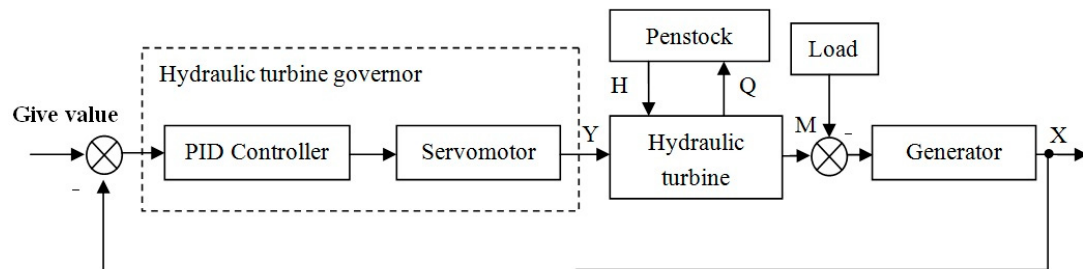
Figure 5. Diagram of the structure of HTGS.